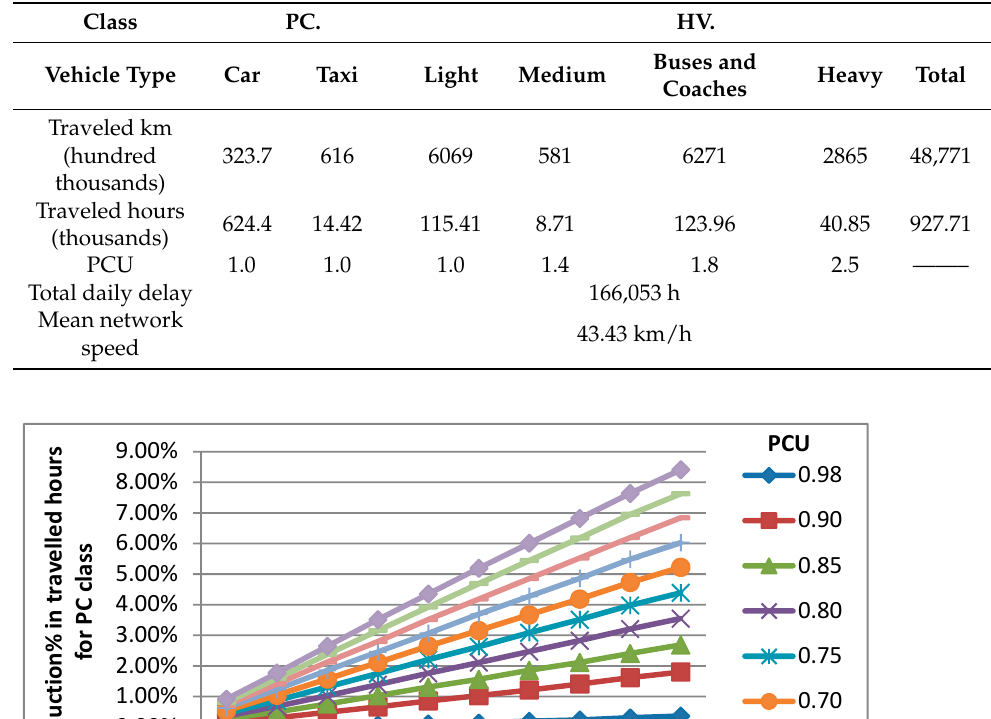
Table 1. Traffic parameters of base scenario.